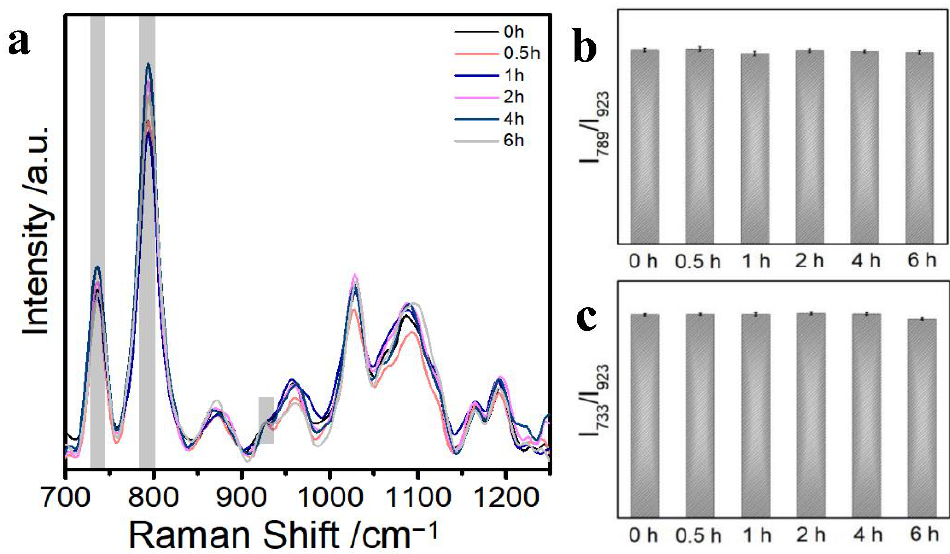
Figure 4. ( a ) SERS spectra of Au@AgINPs and D3 at different reaction times; ( b ) histogram of I 789 /I 923 values corresponding to changes in cytosine and thymine (C + T) of D3; ( c ) histogram of the I 733 /I 923 values corresponding to the changes in adenine (A) of D3.